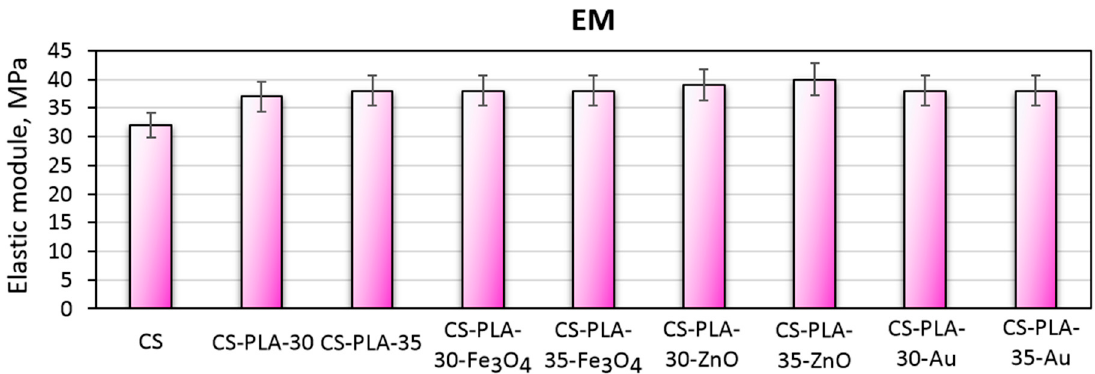
Figure 8. Elastic modulus of the prepared scaffolds.